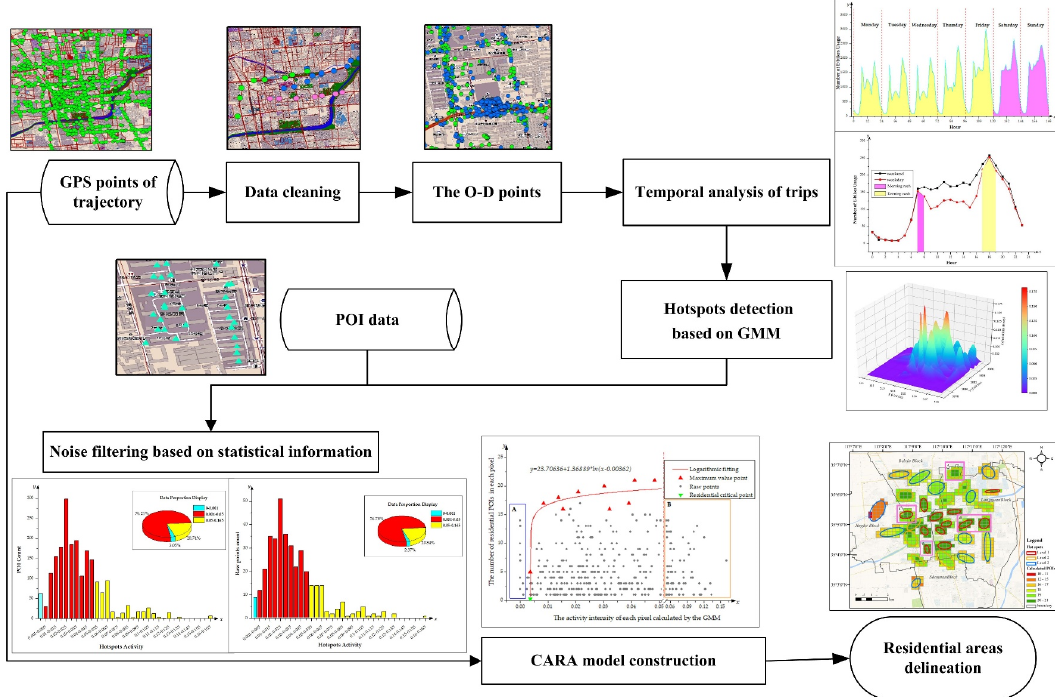
Figure 2. The overall workflow of the study.